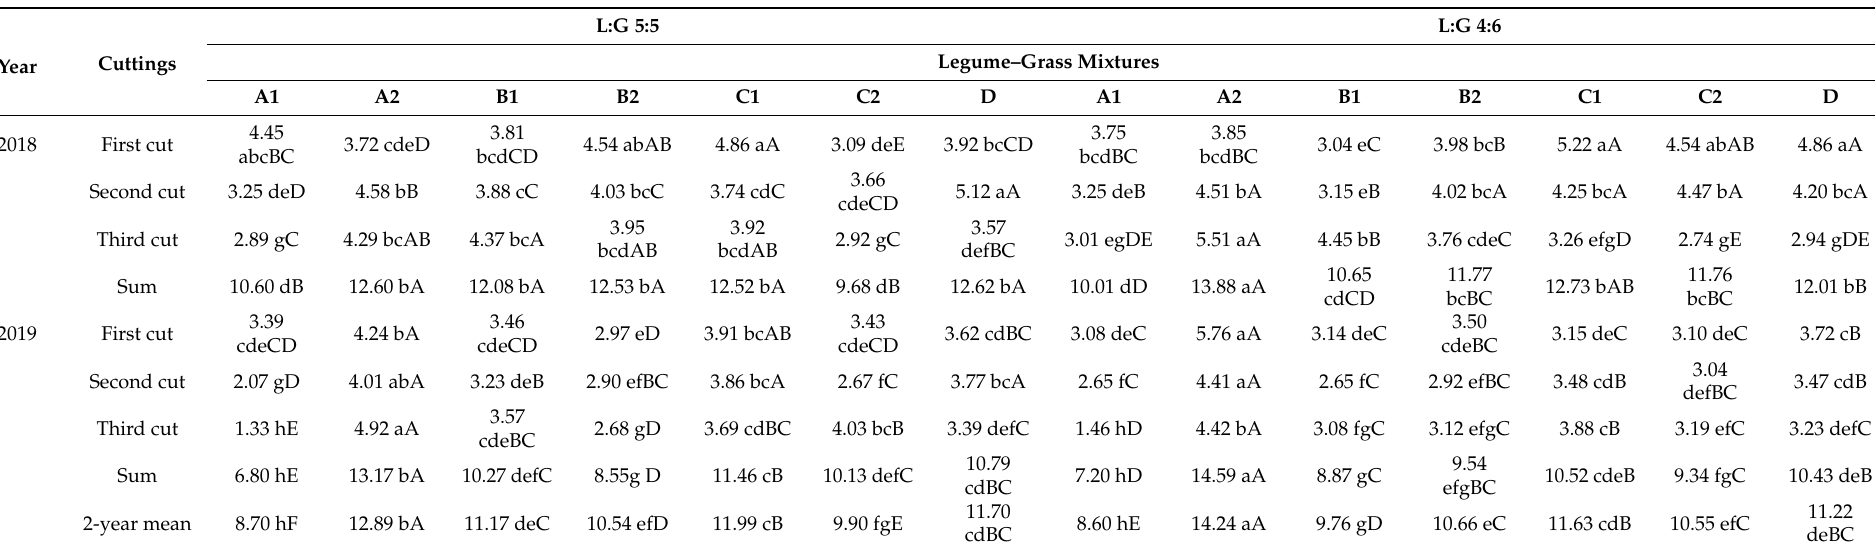
Table 4. Biomass yield (t/ha) of legume–grass mixtures in different legume-grass seeding ratios for two consecutive